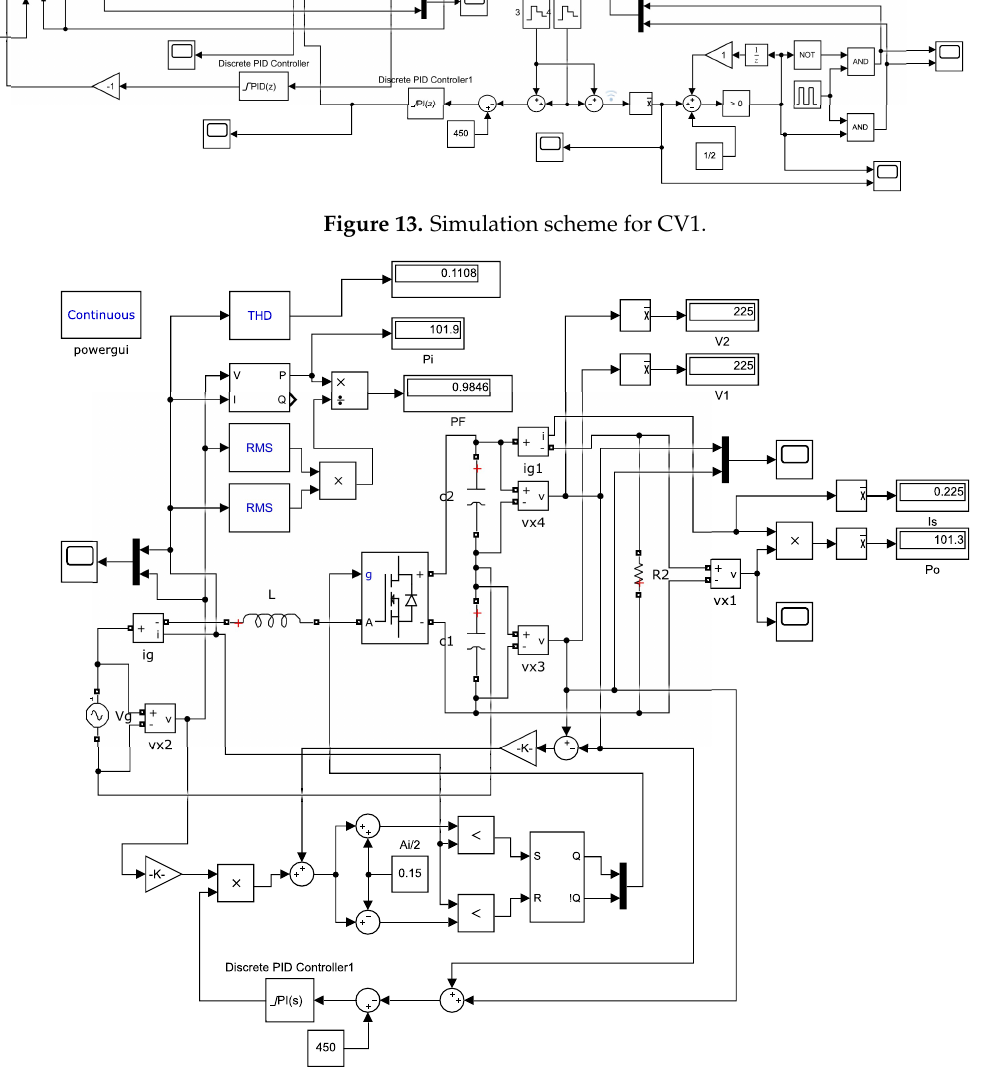
Figure 14. Simulation diagram for